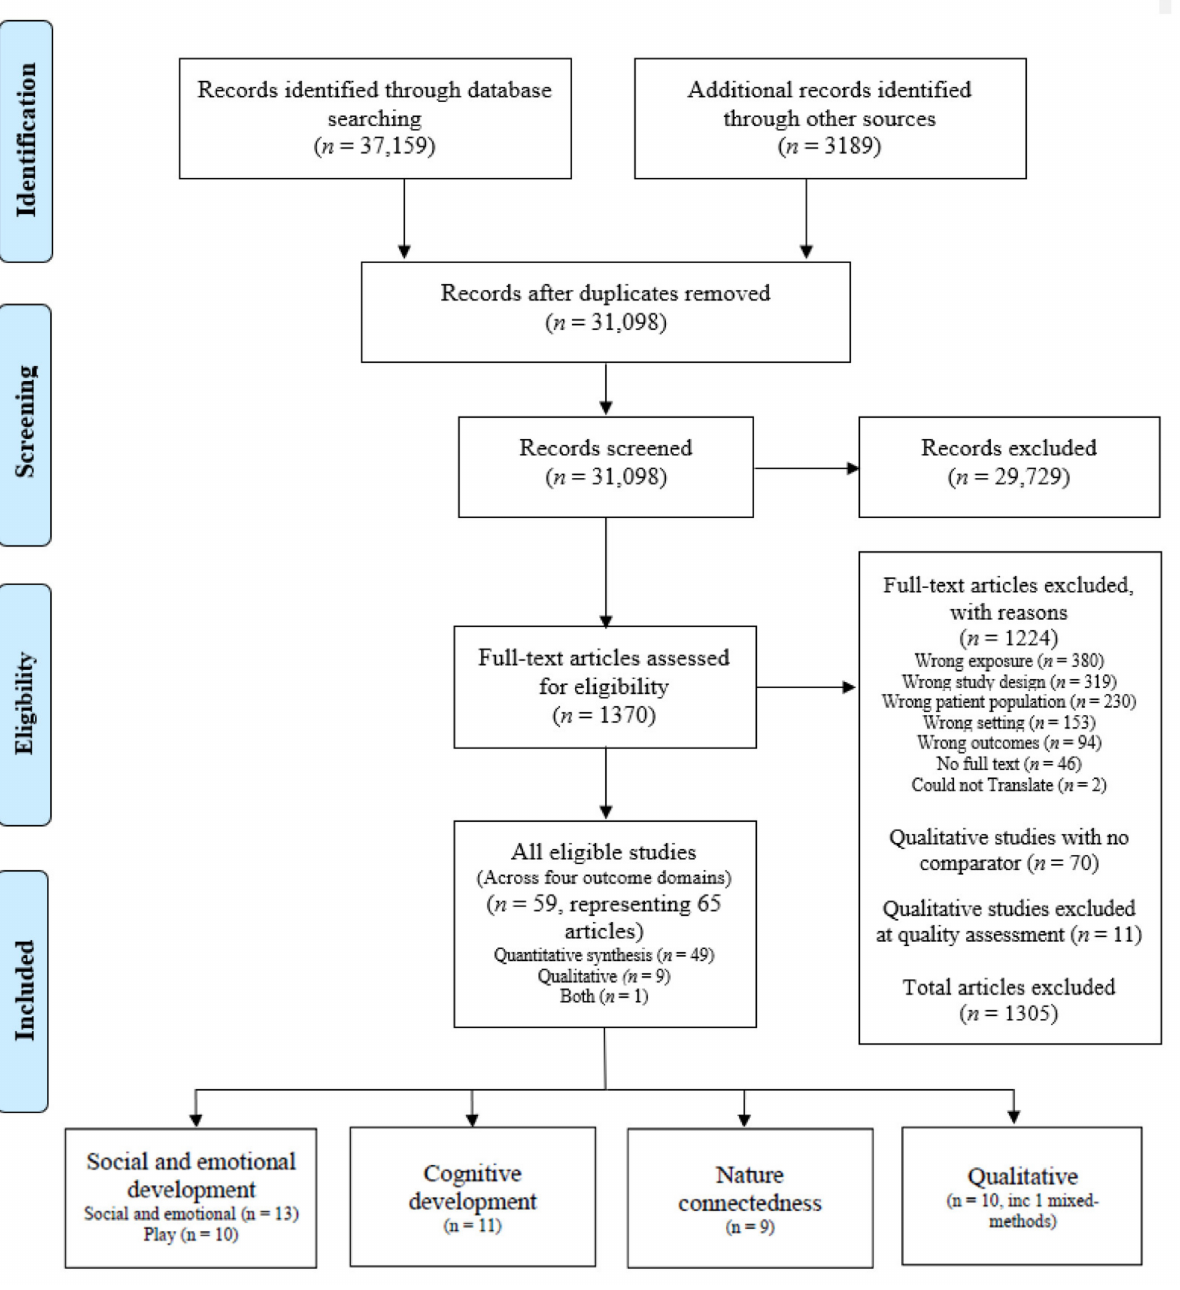
Figure 1. Results from the literature